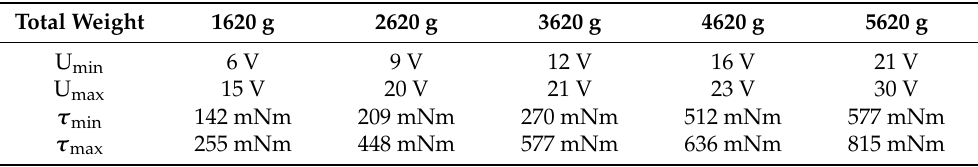
Table 6. Appropriate operating ranges for rotation around Piezo